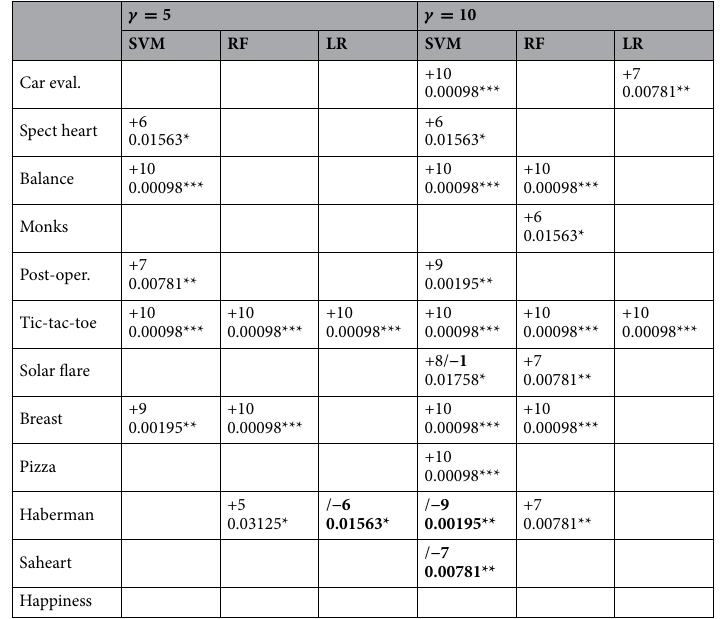
Table 8. Number of runs (of the possible 10) for which there is statistical evidence in favor of BOSME (positive number, counter + ) or SMOTE (negative in bold, counter − ), and the corresponding exact Binomial p value, for any data set with significant differences, and classifier: Support Vector Machine (SVM), Random Forest (RF) and Logistic Regression (LR). γ = 5, 10